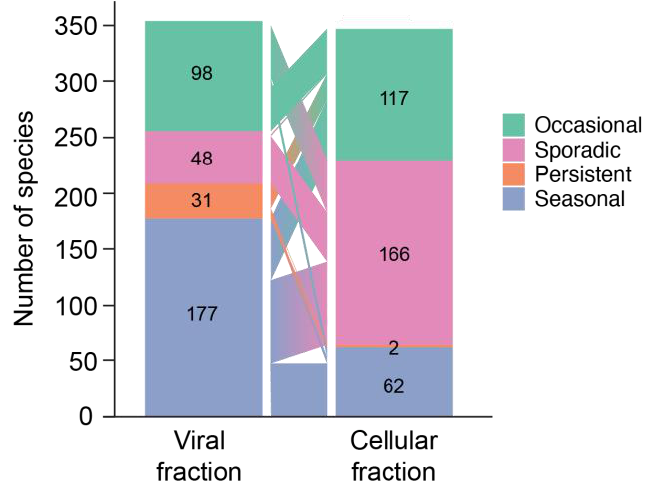
Figure 3. The number of species categorized to each dynamic class (seasonal, persistent, occasional, and sporadic) in the viral and cellular fraction metagenomes (left and right bars, respectively) and an accounting of how each species is categorized differently between each sample type (trapezoids in the middle). Note that seven species detected in the viral fraction metagenomes were not detected in the cellular fraction metagenomes.